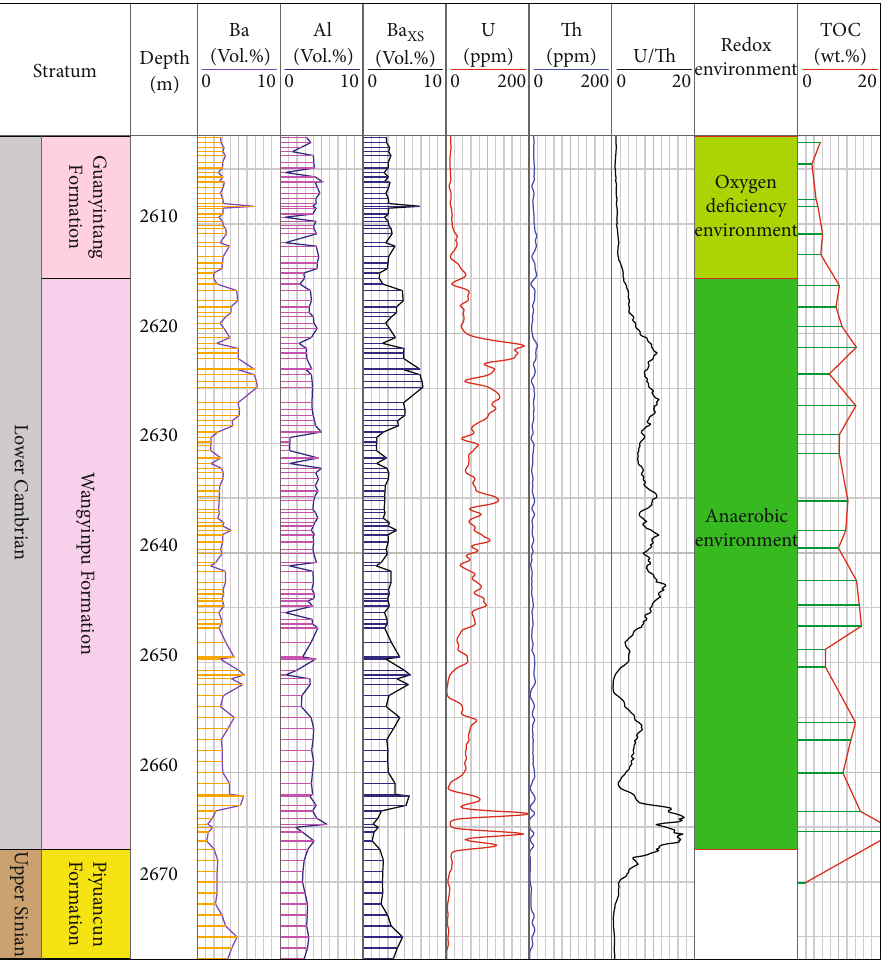
Figure 2: Bioproductivity (Ba ), redox environment, and TOC content of JXY1 well in the lower Cambrian Wangyinpu Formation in the XS Yangtze Area (see Figure 1 for the well